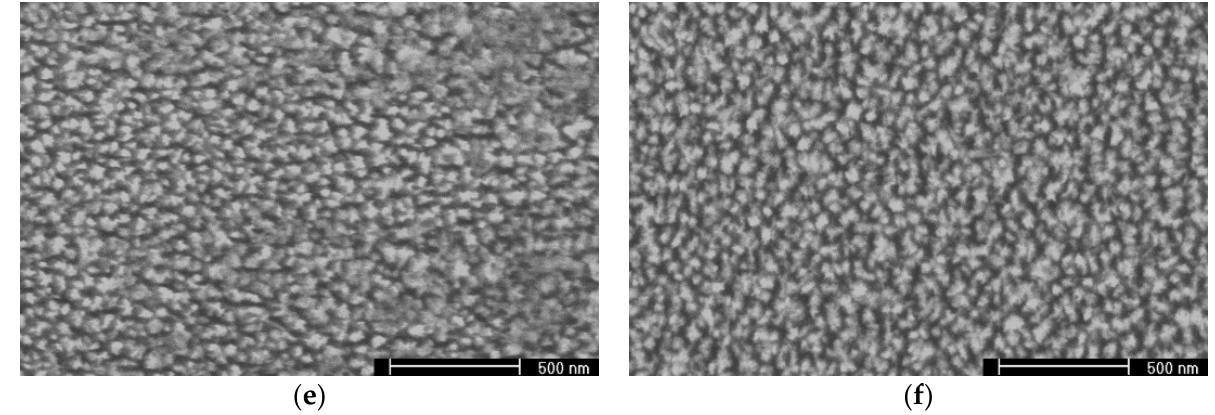
Figure 1. Top-view SEM images of the as-deposited and plasma-treated GAZO films: ( a ) as-deposited, hydrogen-plasma-treated for ( b ) 1 min, ( c ) 3 min, ( d ) 5 min, ( e ) 7 min and ( f ) 10 min. The crystalline structure of the films was observed by XRD spectra for both plasma- treated and as-deposited films and is shown in Figure 2. According to the standard ZnO XRD pattern from the Inorganic Crystal Structure Database (ICSD) with card number 31052, the diffraction peak values of 34.50 ◦ can be indexed to (002) crystal planes. As shown in Figure 2a, only one peak was exhibited in the diffraction angle (2 θ ) range 30–60, corresponding to the (002) of ZnO. The corresponding (002) peak locations of the XRD spectra are listed in Table 1. The two theta angles between 33.5 ◦ and 35.5 ◦ in Figure 2a are enlarged and shown in Figure 2b.